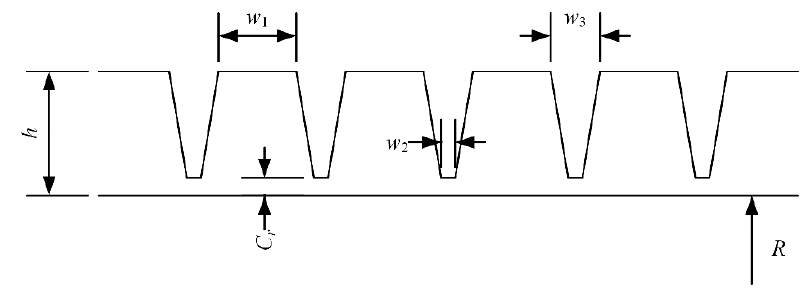
Figure 8. Geometry of labyrinth seal. Table 1. Geometry parameters and operating conditions [14].